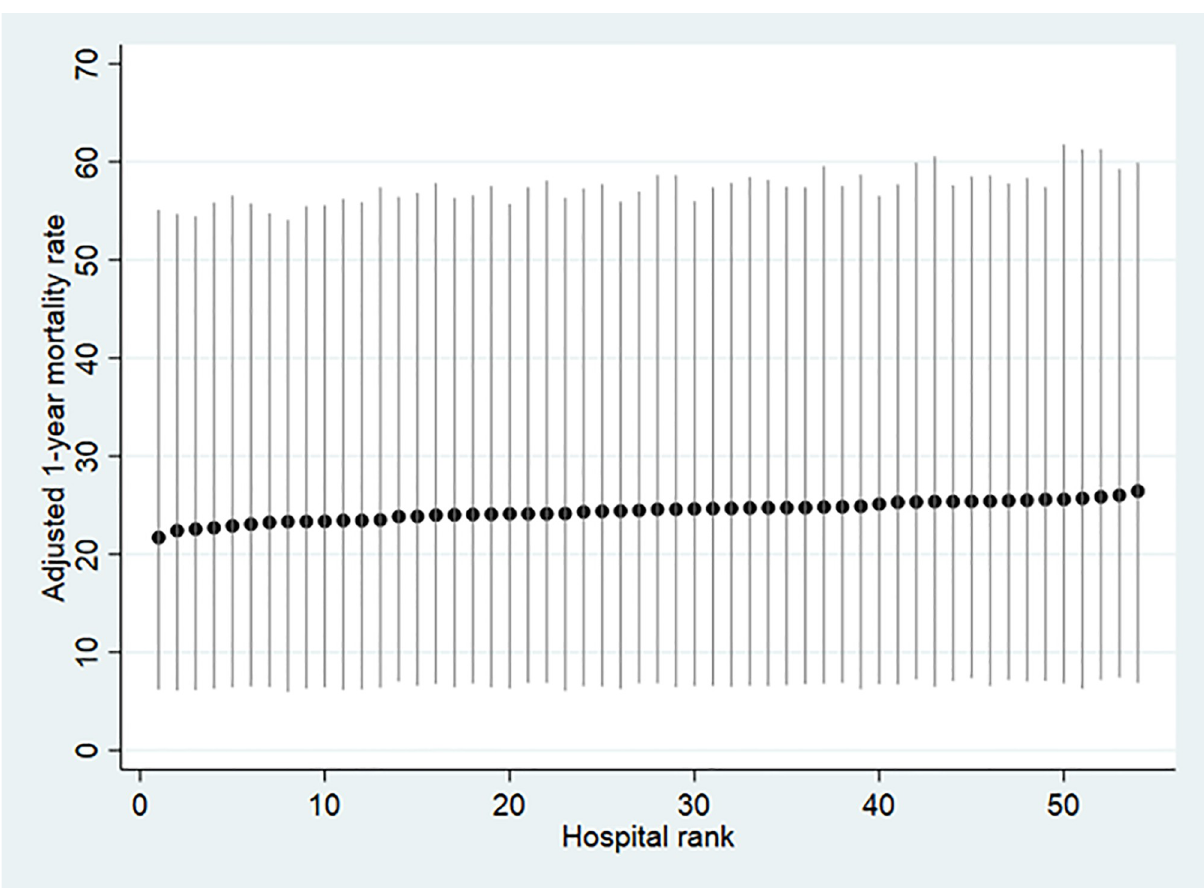
Fig 2. League table ranking the 54 hospitals according to their adjusted absolute risk of 1-year mortality with 95% confidence intervals obtained from the cross-classified multilevel model.